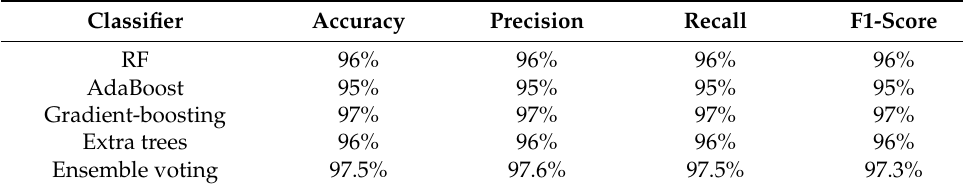
Table 1. Results of all machine learning models using the split-test training method.